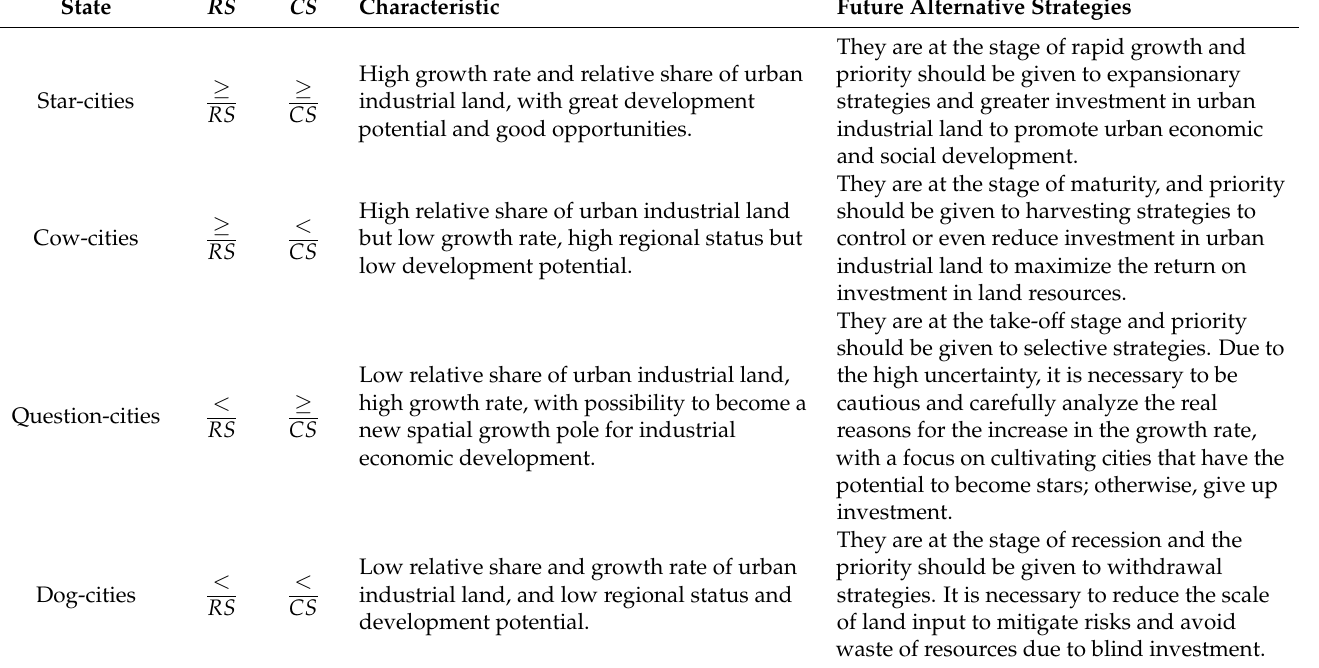
Table 2. Decoupling type and decoupling indicator